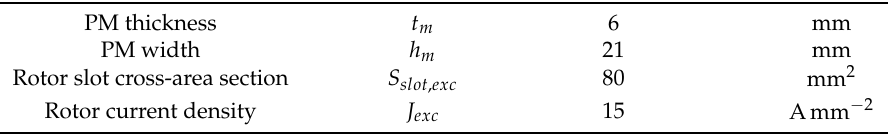
Table 2. IPM and SRC-6 rotor